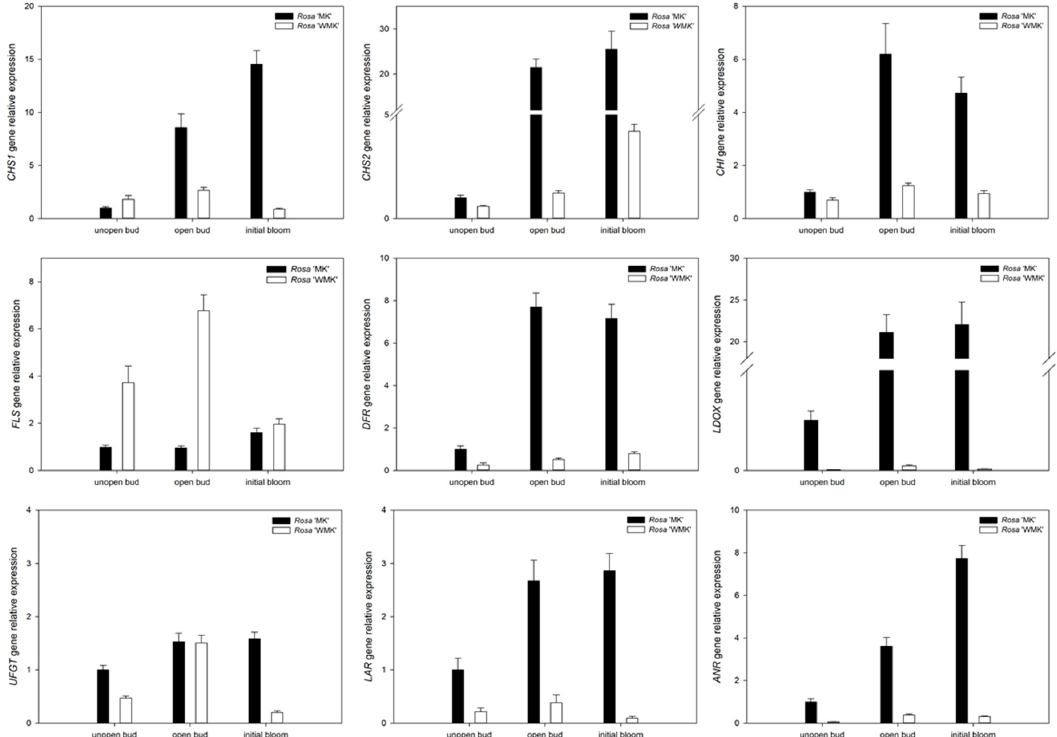
Figure 4. Graphs showing gene expression in the anthocyanin biosynthesis pathway. Key enzymes and their di ff erential gene expression during flowering stages (unopened bud, opened bud, and initial bloom) were analyzed by qRT-PCR. The expression level of each gene is relative to that of ACTIN reference in Rosa ‘Margo Koster’ at unopen bud stage. Each data point is the average of three biological repeats. Error bars indicate standard deviations (SDs). CHS, chalcone synthase; CHI, chalcone isomerase; FLS, flavonol synthase; DFR, dihydroflavonol-4-reductase; LDOX, leucoanthocyanidin dioxygenase; UFGT, anthocyanidin-3- O -glucosyltransferase; ANR, anthocyanidin reductase; LAR, leucoanthocyanidin